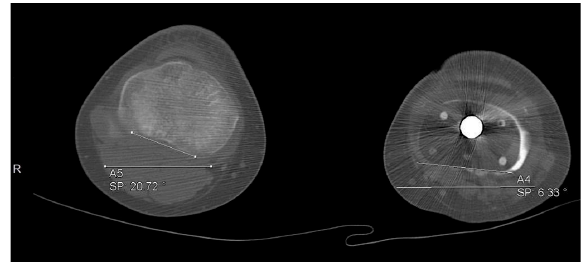
Figure 5. Rotational deformity of 26 degrees in one of our patients.